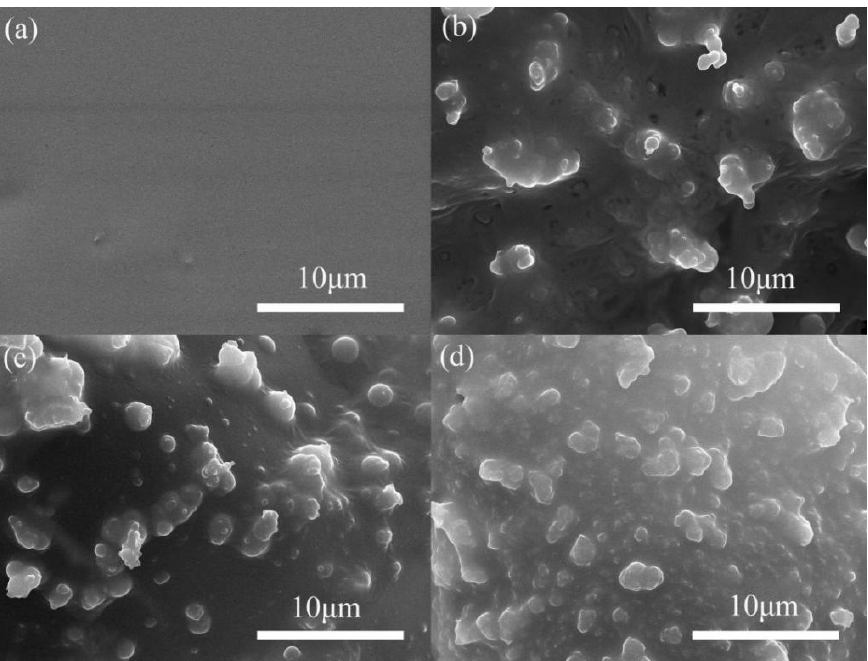
Figure 9. SEM images of the coatings ( a ) without microcapsules and with ( b ) 5%; ( c ) 10%; and ( d ) 15% microcapsules.